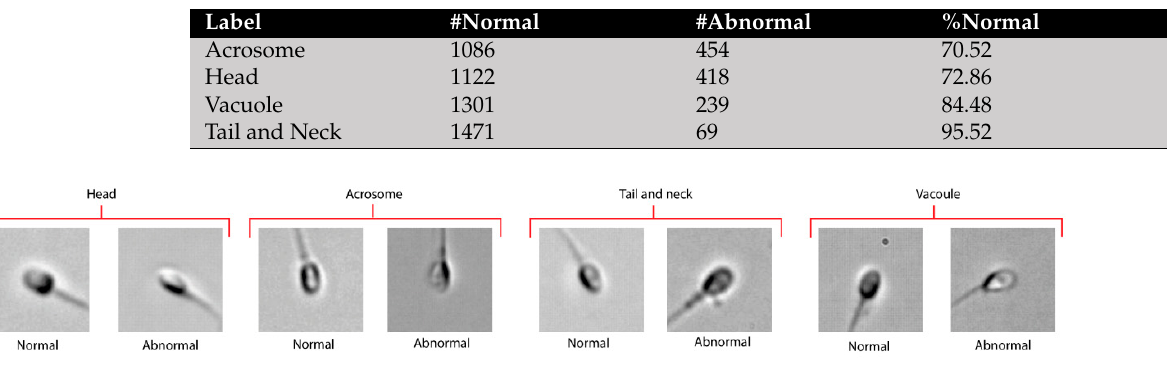
Figure 2. Division of MHSMA dataset